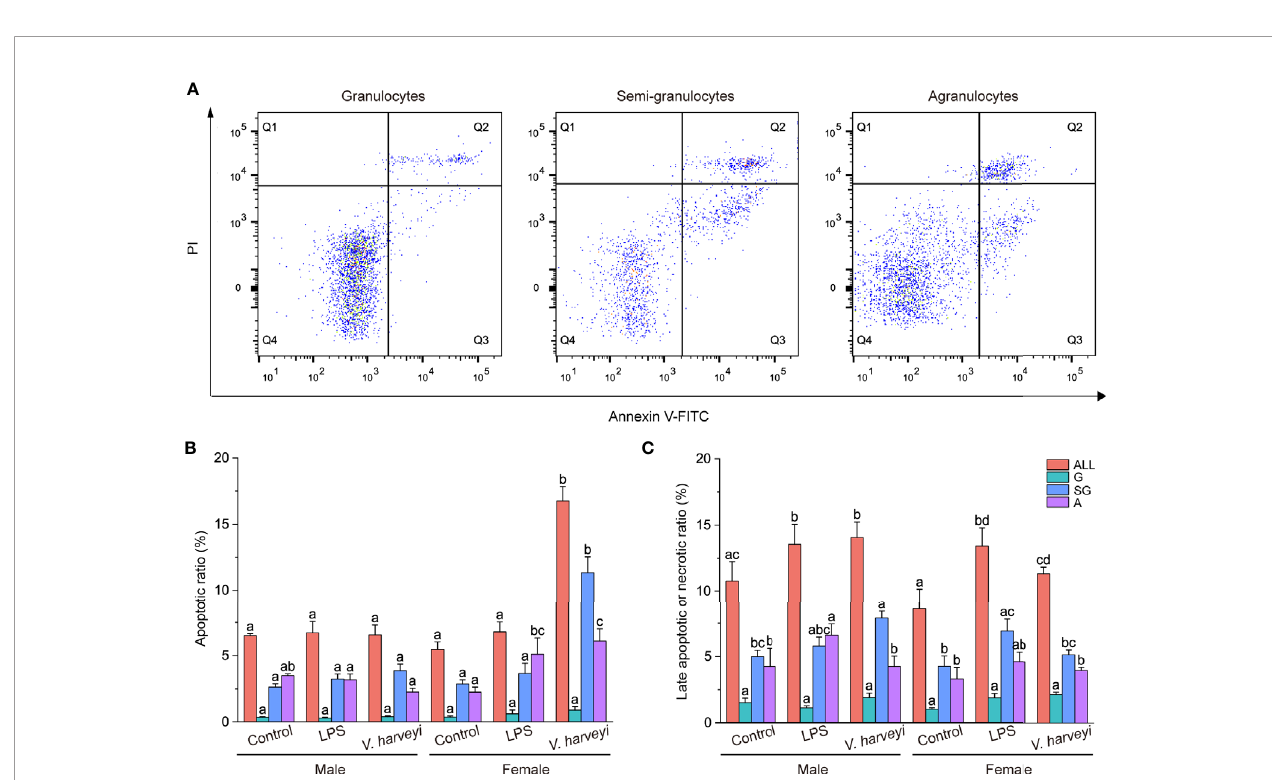
FIGURE 4 | Results of the annexin V-FITC and propidium iodide (PI) assay. (A) Representative scatter diagrams of three hemocyte subpopulations from C. hongkongensis . (B) Early apoptotic hemocyte ratios of different hemocyte subpopulations. (C) Late apoptotic or necrotic hemocyte ratios of different hemocyte subpopulations. The means denoted by different letters for each fi xed hemocyte subpopulation are signi fi cantly different among different treatments ( p < 0.05). G, granulocytes; SG, semi-granulocytes; A, agranulocytes.